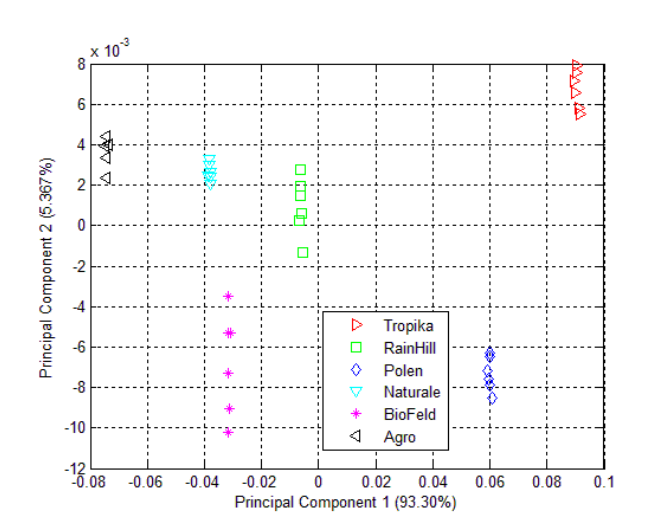
Figure 6. PCA plot using data fusion